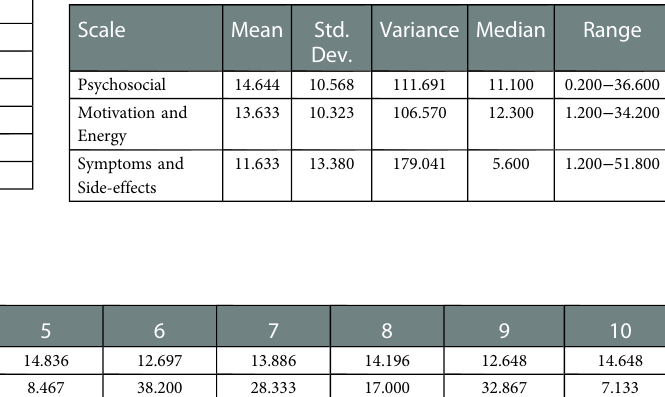
Table 6 RMSE and MAE scores for each